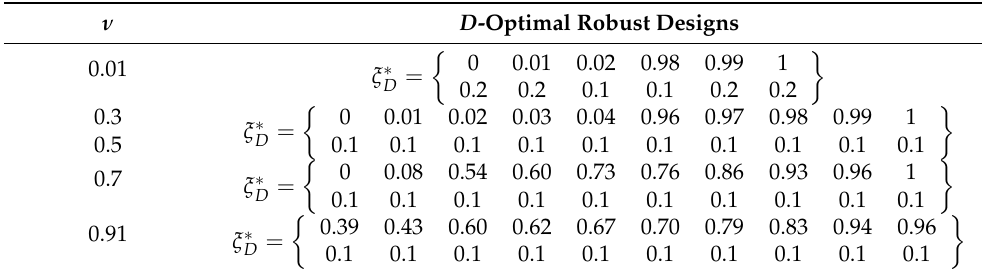
Table 2. 10-point D -optimal robust designs computed for the log-logistic model.